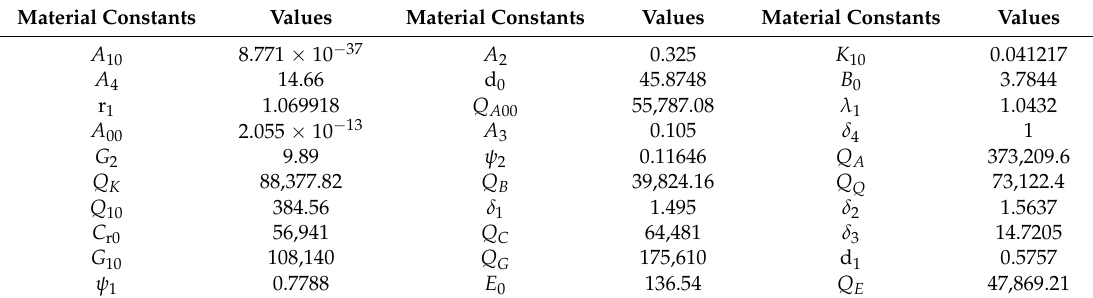
Table 5. Determination of material constants of constitutive